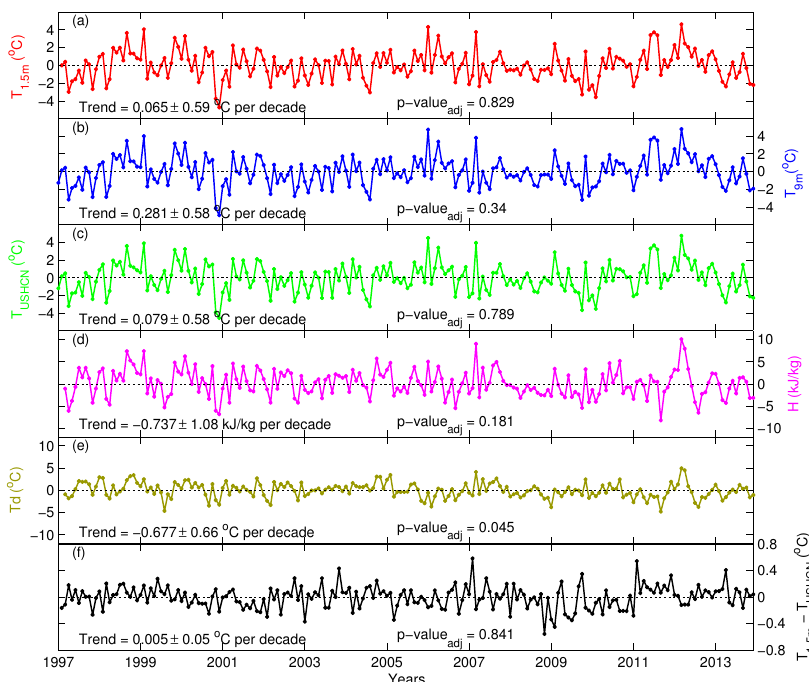
Figure 2. Monthly time series of (a) surface temperature at 1.5m ( T 1.5m ) , (b) surface temperature at 9m ( T 9.0m ) , (c) USHCN surface temperature ( T USHCN ), (d) near-surface air heat content ( H ) at 1.5m, (e) surface dew point temperature ( T d ) , and (f) surface temperature difference between T 1.5m and T USHCN . The ± values define the 95% confidence intervals for specific trends shown in each panel. The first 2months of H and T d and the first month of T 1.5m were missed due to fewer available